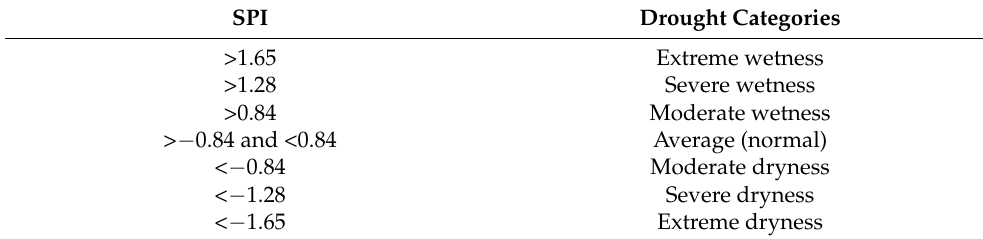
Table 2. SPI drought categories